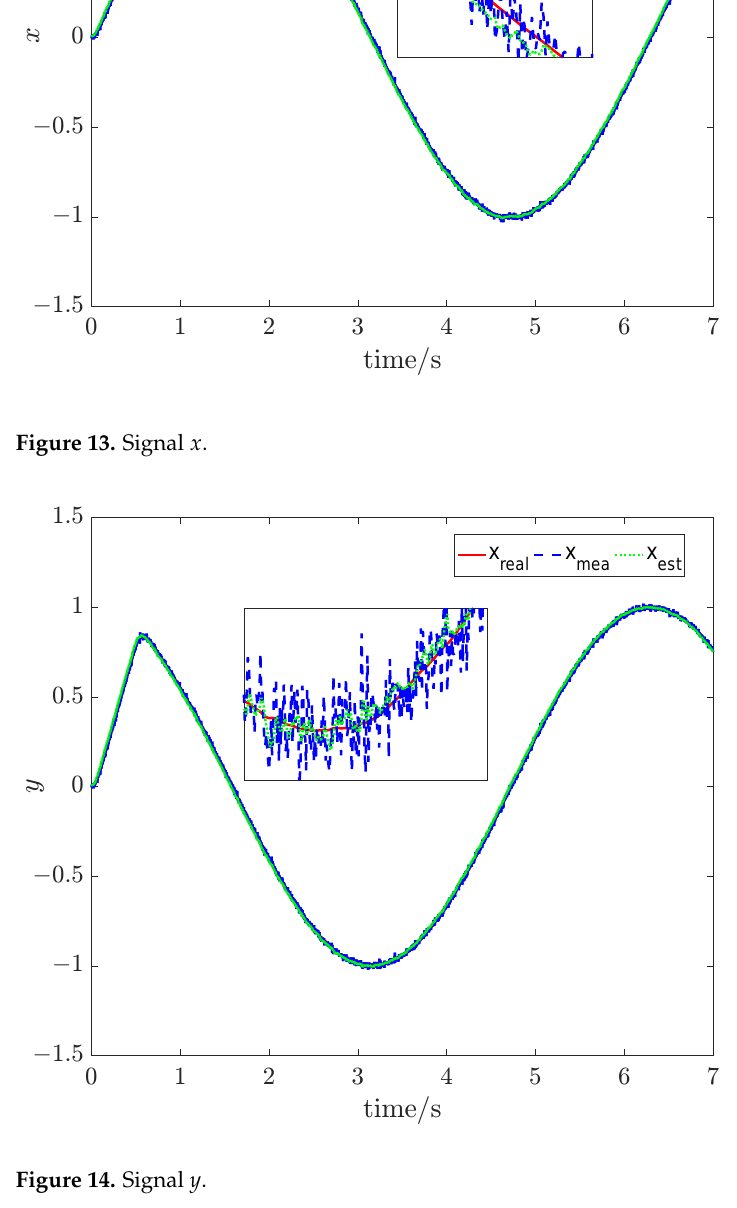
Figure 14. Signal y